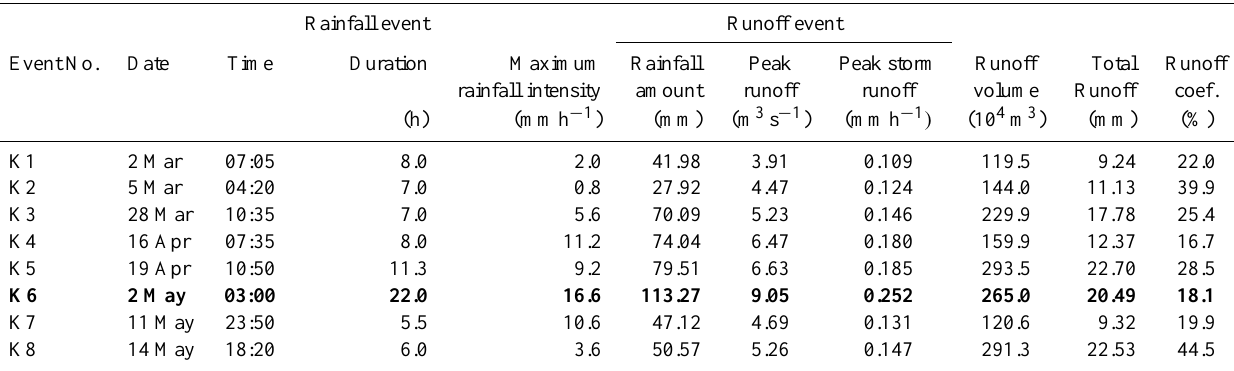
Table 1. Rainfall-runoff events during Itumba’10 season in the Kansi sub-catchment (129.3km 2 ). The in-detail investigated event K6 is given in bold.